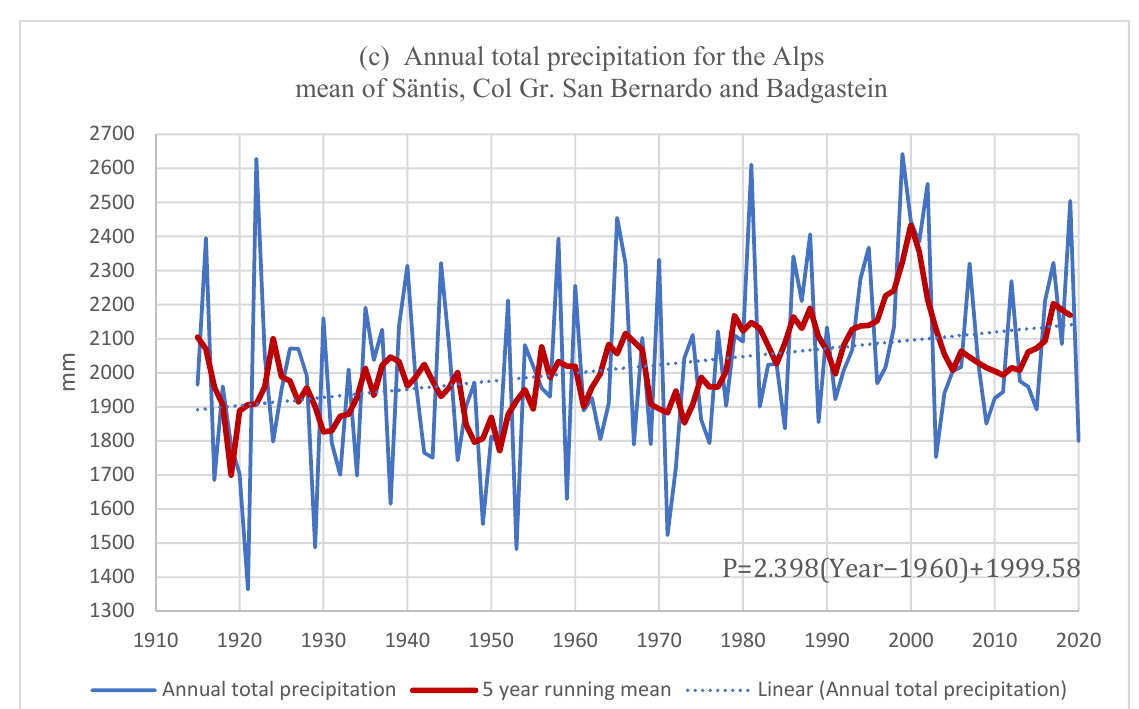
Figure 1. The equilibrium line altitude (ELA) of the Claridenfirn and the climatic condition: ( a ) Annual ELA from 1915 to 2018; ( b ) Summer mean temperature (JJA) of the Alps, based on Sonnblick (3105 m), Säntis (2501 m) and Col Gr. San Bernardo (2472 m); ( c ) Annual total precipitation for Alps, mean of Säntis, Col Gr. San Bernardo and Badgastein (1094 m). The thick red lines are 5-year running means, while the dotted lines are linear regression lines from 1915 to 2020. The equations for the regression lines are provided at the right-bottom corners.